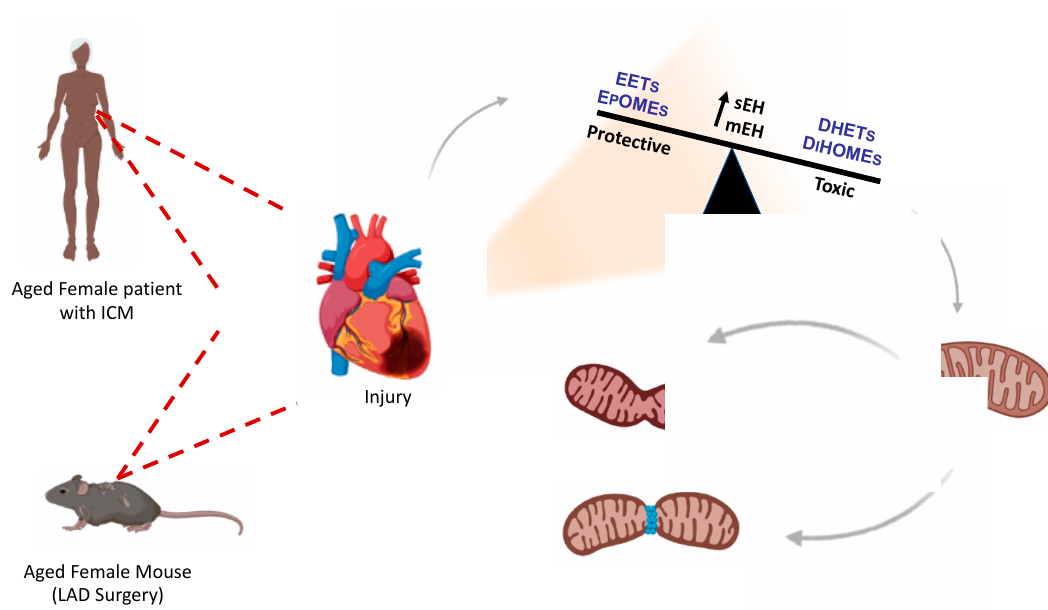
Figure 7. A proposed mechanism of protection arising from sEH inhibition or deletion in female hearts. Hearts where sEH activity is not inhibited are marked by increased mitochondrial dysfunction, manifesting with disrupted dynamics, impaired electrical signalling, and mechanical function at 28-days post-ischemia. This was associated with increased diol metabolite formation. In contrast, female hearts where sEH is genetically deleted or pharmacologically inhibited are marked by reduced mitochondrial dysfunction, cumulating in preserved ATP production and slowing the progression of cardiac dysfunction. Interestingly, pre-treatment with sEHi demonstrates a higher degree of cardioprotection, suggesting sEHi protection is time-dependent.